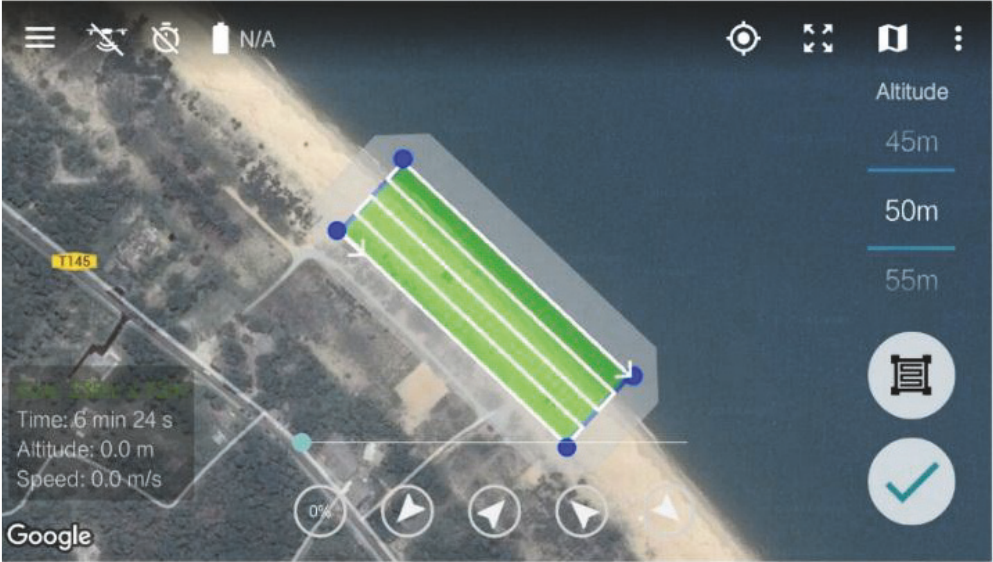
Figure 5: Flight path on flight planning.